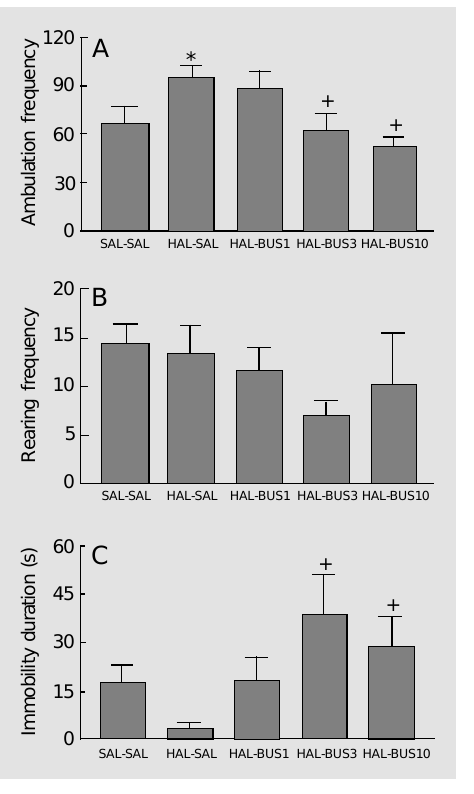
Figure 1. Effect of acute admin- istration of buspirone (BUS) or 0.9% NaCl (SAL) on ambulation frequency (A), rearing frequency (B) and immobility duration (C) of mice withdrawn from long- term haloperidol (HAL - 2.5 mg/ kg) or SAL treatment (once daily, for 20 days) and observed in an open-field. The doses of buspi- rone are reported as mg/kg. *P<0.05 compared to SAL-SAL group; + P<0.05 compared to HAL-SAL group (ANOVA fol- lowed by the post hoc Duncan